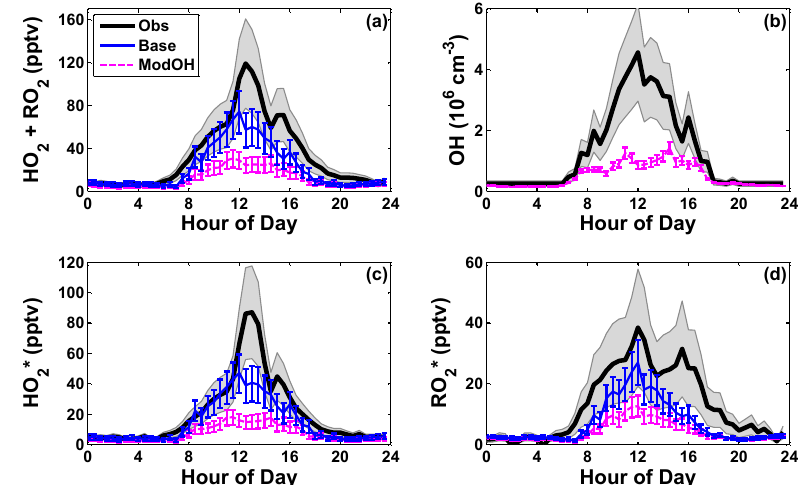
Fig. 3. Comparison of RO x observations with 0-D model results. Solid black lines with shaded gray areas represent observations and their associated uncertainties. Model scenarios include the base (solid blue line) and ModOH (dashed magenta line) simulations; in the latter case, OH concentrations are not constrained to observations. For comparison with HO ∗ subdivided into two groups as described in the text. Calculation of model uncertainties is described in the Supplement.